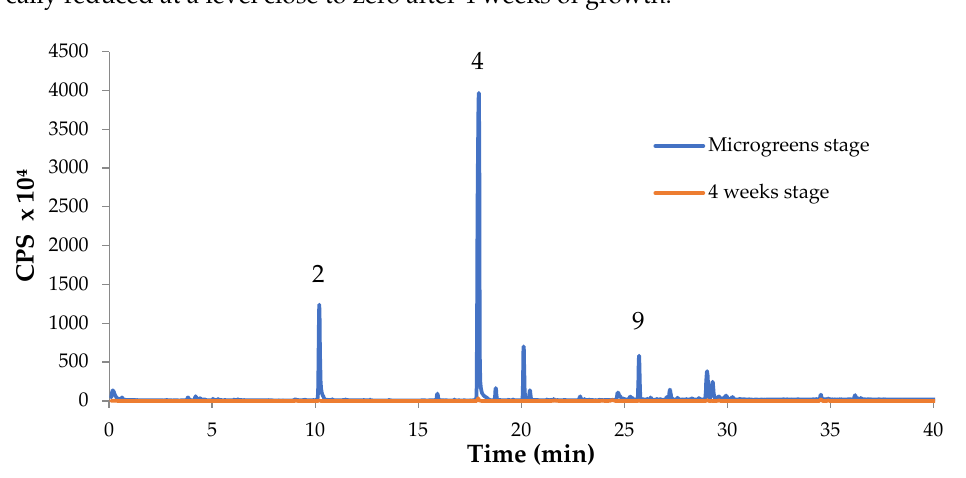
Figure 4. Comparison of VOCs of Chinese green basil (var. frutescens ) at microgreens stage and after 4 weeks of further growth. The numbers of the peaks correspond to the volatile compounds identified (see Table 4).